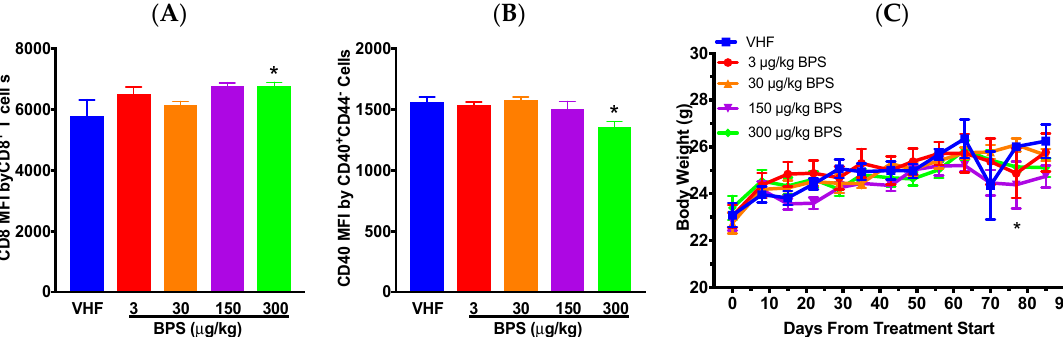
Figure 2. Flow cytometric analysis and body weight in female NOD mice on the soy-based diet. The expression of CD8 by CD4 − CD8 + cells ( A ) and of CD40 by CD40 + CD44 – cells ( B ). N = 3 for the VHF and 150 µ g / kg dose groups; N = 6 for the 3 and 30 µ g / kg dose groups; N = 5 for the 300 µ g / kg dose group. ( C ) Changes in body weight over time ( N = 4–6). The values are presented as mean ± SEM. *, p < 0.05 for 300 µ g / kg BPS vs. VHF group.